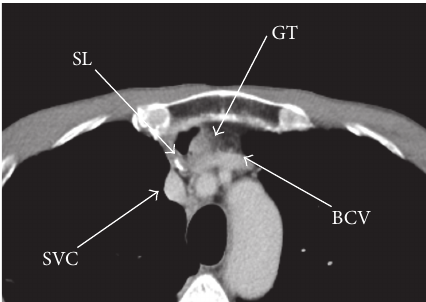
Figure 3: Computed tomography of the anterior mediastinum. GT: gastric tube, SL: staple line, SV: superior vena cava, and BCV: brachiocephalic